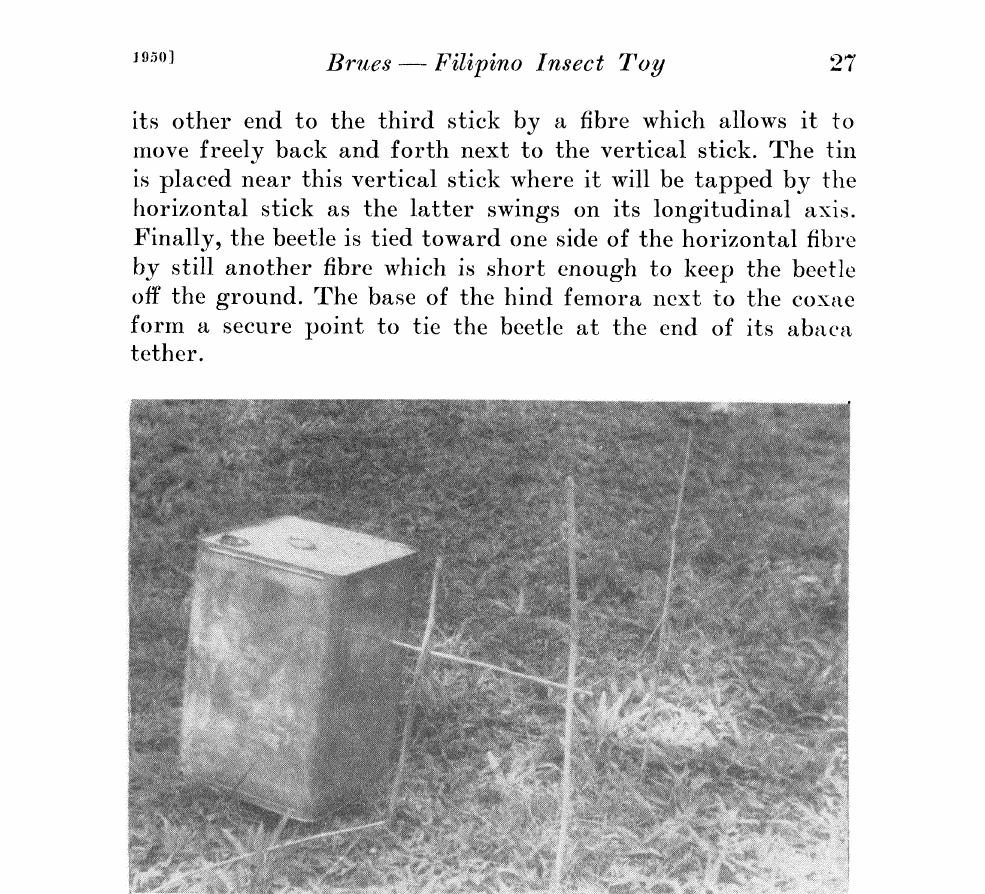
Fig. 1. The salagubong gong. The oil can which acts as a resonator is shown at the left. The first pair of bamboo .sticks mentioned in the text are at the right, connected by the thread from which the beetle is